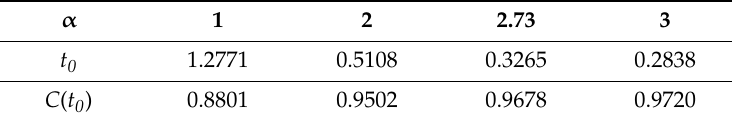
Table 1. Absorption parameters versus